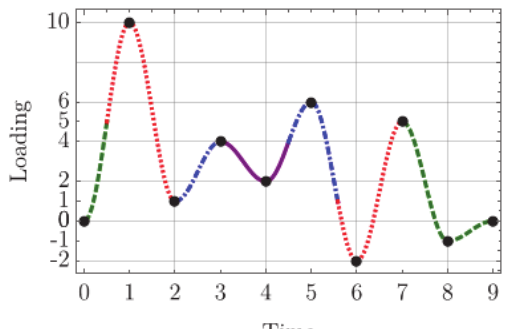
Figure 3: Schematic representation of the 4-point rainflow counting algorithm, that keeps time intervals in which cycles occur. Parts of the time-history of the same colour and dashing belong to a single